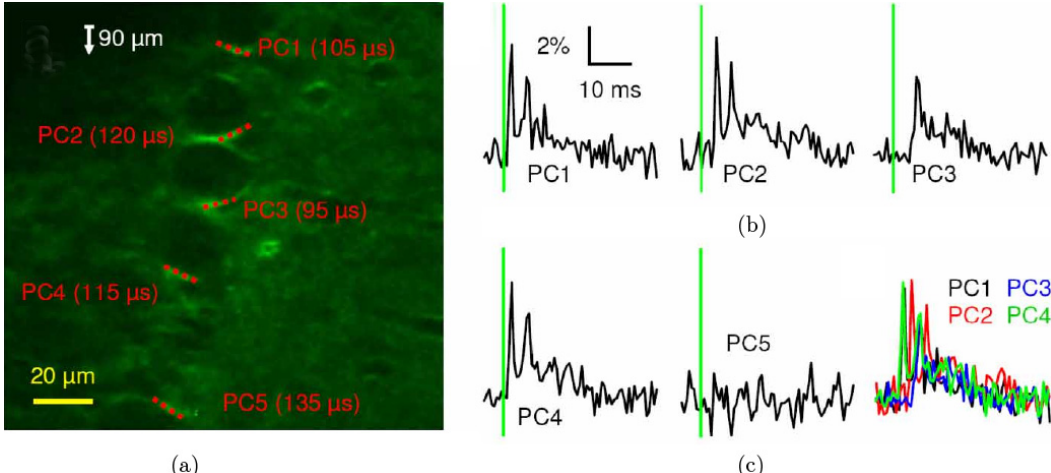
Fig. 7. Optical multi-unit recording of stimulated electrical activity. (a) SHG image of a cerebellar slice taken at a depth of 90 (cid:1) m. The multi-unit SHG recording was carried out from the lines drawn (dotted red) on the 5 Purkinje cells (PCs), with the integration time per membrane pass indicated. (b) Multiplexed recording of action potentials from the 5 PCs following stimulation of climbing ¯bers (green lines). The relative SHG variation ( (cid:1) SHG/SHG) is shown as a function of time. Each trace represents the average of 20 trials for each PCs. The time resolution is 0.47 ms. (c) Superposition of SHG traces corrected for multiplex delay is shown. PC5 is not shown since it was quiescent. From Ref. 107.